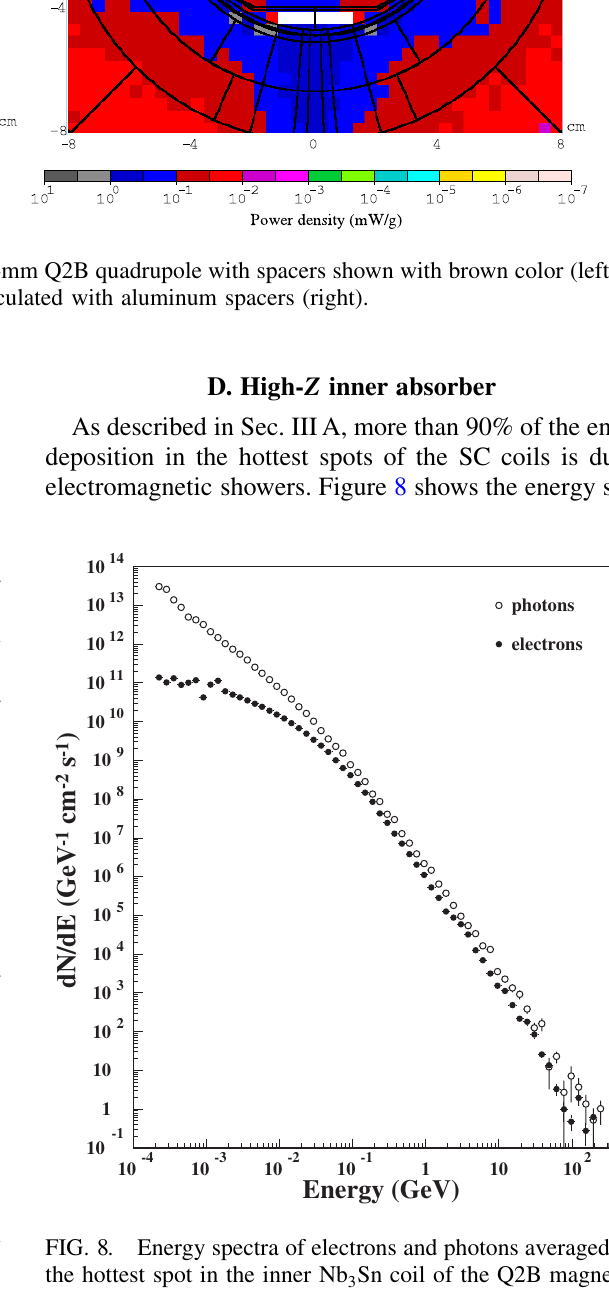
Sn coil of the Q2B 3